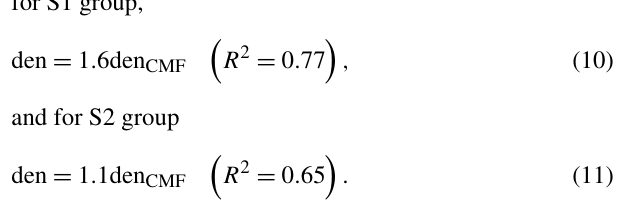
Figure 12. Time series of estimated and observed density for an approximately half-day period. Density observed in 11 snowfall events is indicated with bold horizontal bars, the length of which expresses the time span. Estimated density is indicated as fol- lows: estimated from 5min CMF (crosses); estimated from 5min CMFs and mass flux of each 5min interval for the observation pe- riod (filled circle); estimated from meteorological elements using Eq. (13) (solid line); estimated without wind (dotted line). A5 and G3 correspond to events listed in Table